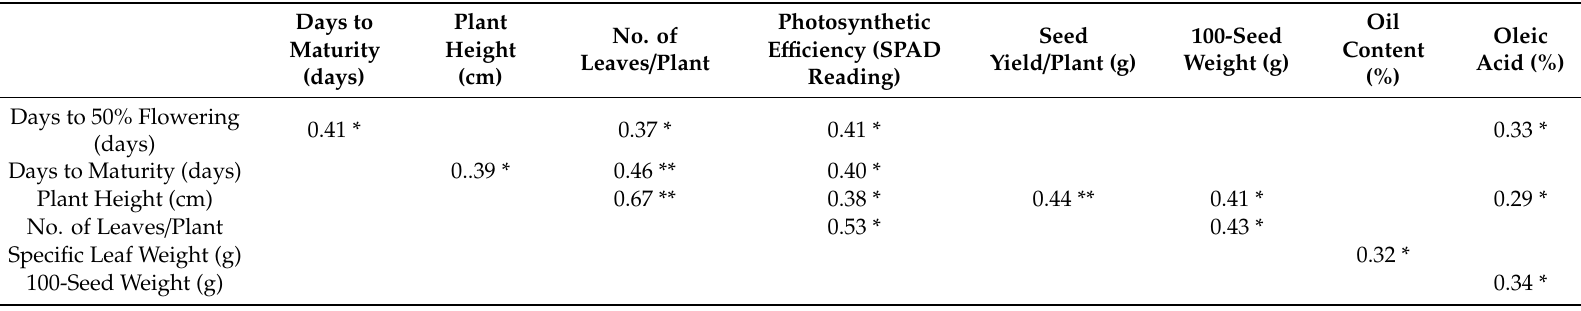
Table 7. Pearson’s correlation coe ffi cients of sunflower hybrids under the regular growth regime with only significant values at p < 0.05 (*) and p < 0.01 (**).